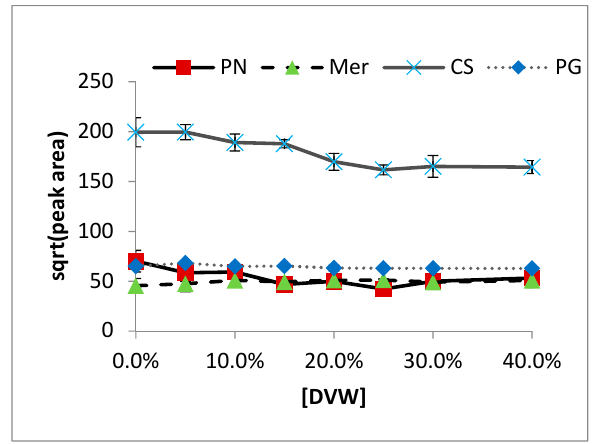
Figure 2. Effects of various DVW matrices on DMS extraction: PN = Pinot noir, Mer = Merlot, CS = Cabernet Sauvignon, PG = Pinot Grigio.